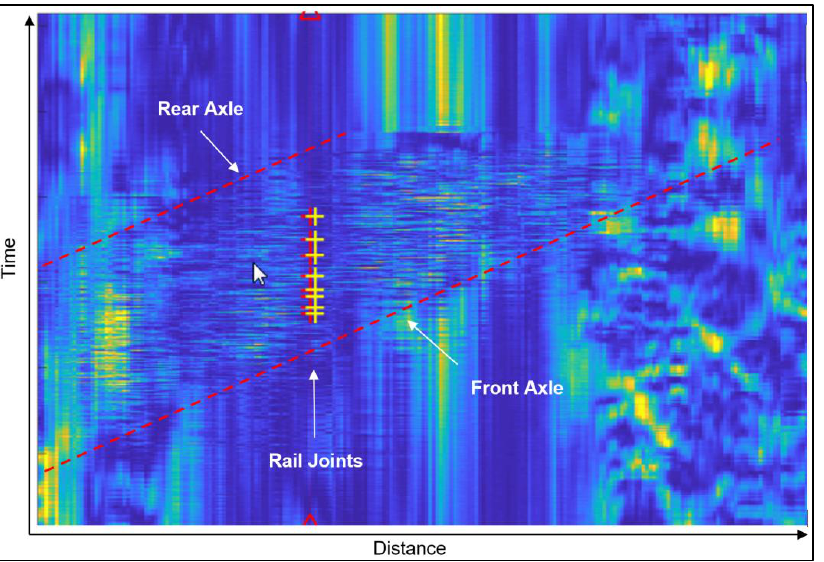
Figure 6 . Raw DAS data with the train position shown in red dashed lines and positions of two rail joints (red and yellow crosses) .